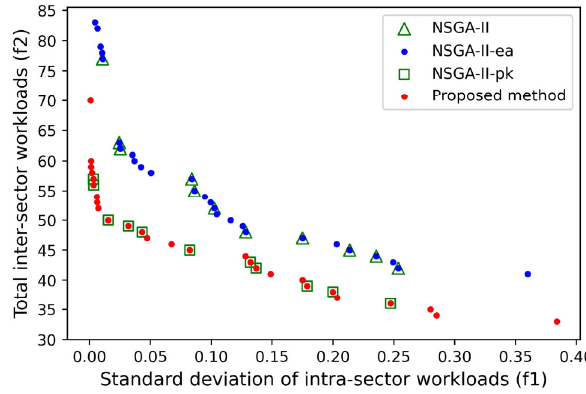
Figure 10. Non-dominated solutions obtained by different algorithms.